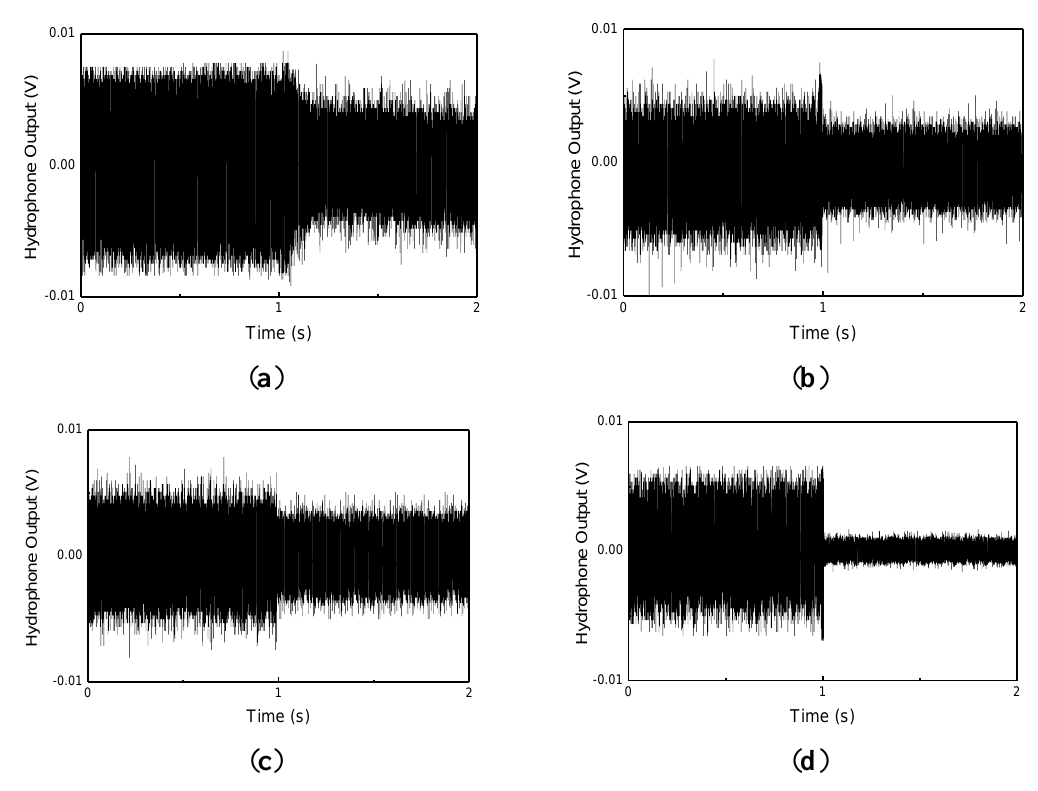
Figure 14. Measured radiating sound under 4th mode excitation ( a ) Hydrophone 2, ( b ) Hydrophone 6, ( c ) Hydrophone 10, and ( d ) Hydrophone 14.